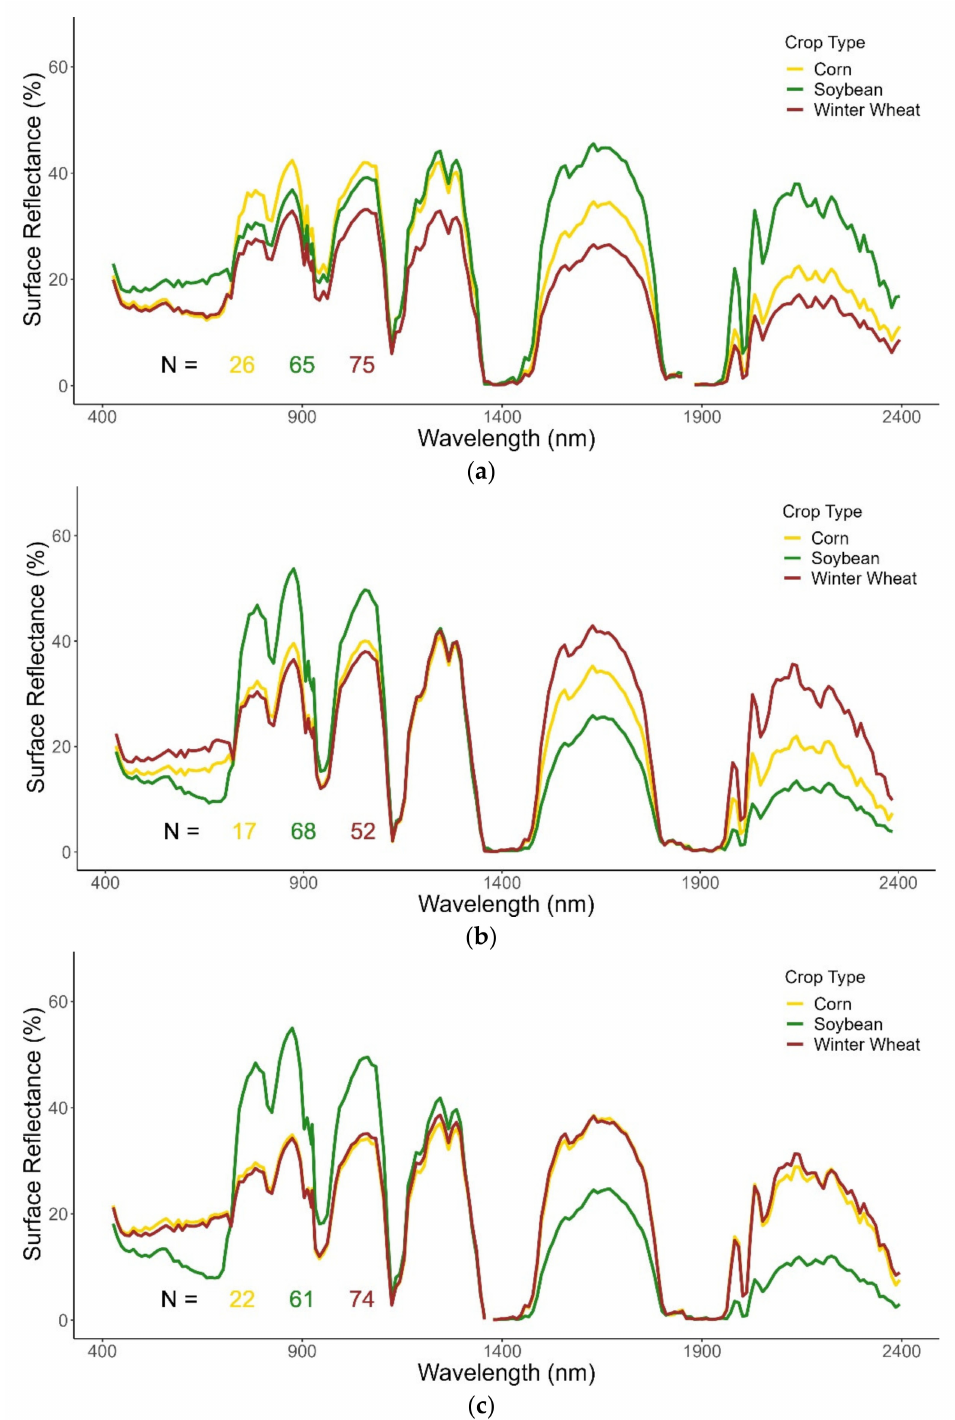
Figure 3. Average Hyperion 2010 (wet year) spectra by crop type for: ( a ) June (Julian Day 152), ( b ) August (Julian Day 222), and ( c ) September (Julian Day 245). N is number of spectra included in the